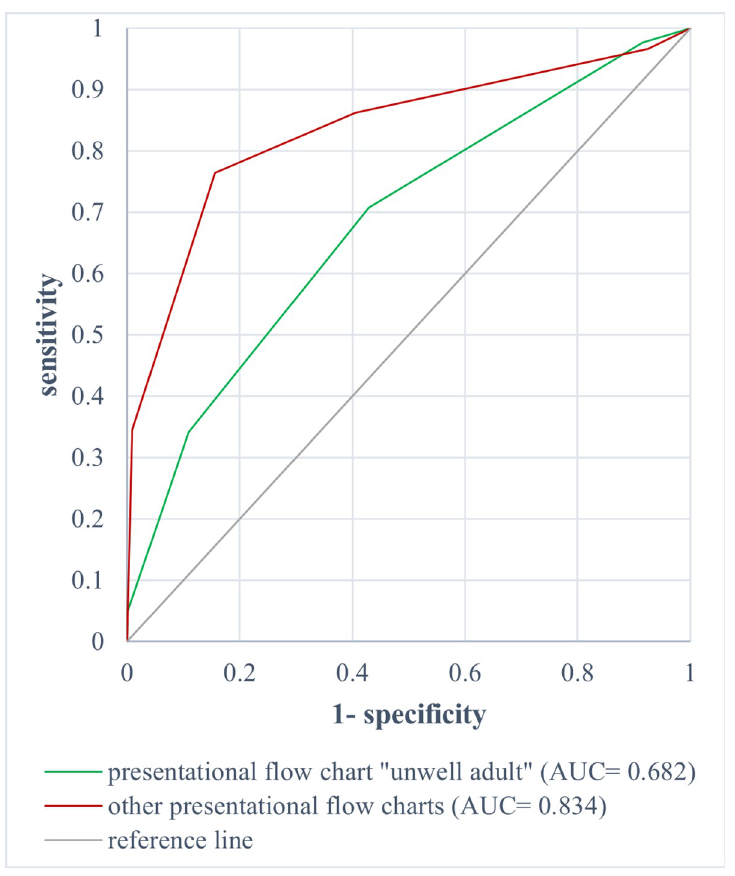
Fig 8. ROC analysis of the MTS level and in-hospital mortality for the presentational flow chart “unwell adult” (AUC = 0.682 [0.595–0.769]) vs. the other flow charts (AUC = 0.834 [0.799–0.869]).